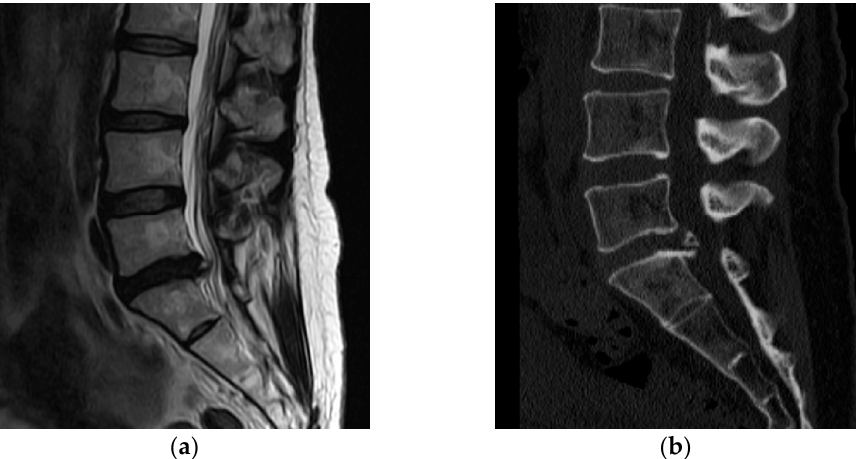
Figure 1. A 43-year-old woman presented with a radiating pain in her left lower extremity. ( a ) Mag- netic resonance imaging (MRI) showed left central herniated disc at the L5/S1 level. ( b ) Computed tomography (CT) revealed a combined posterior ring apophysis fracture at the same level.